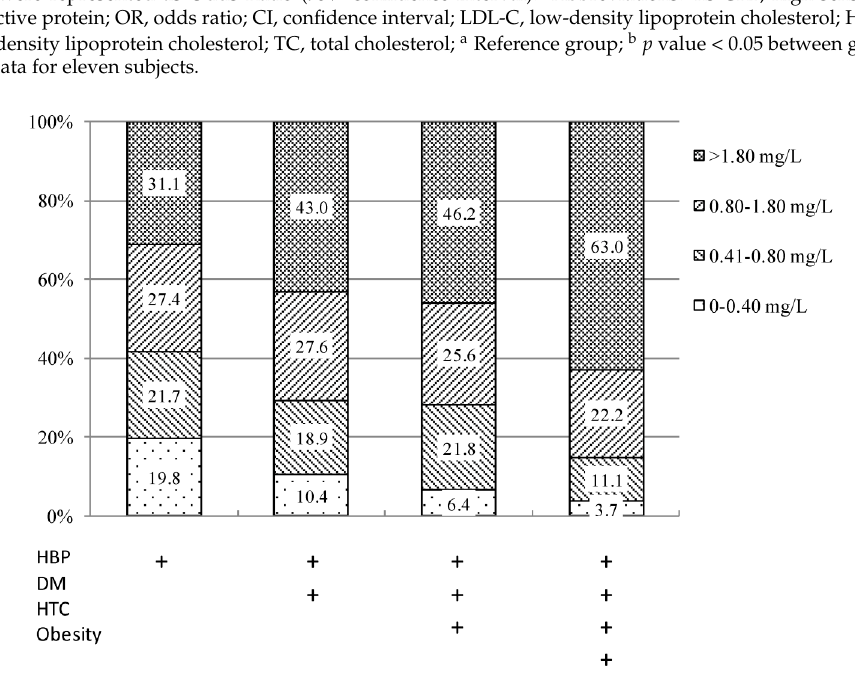
Figure 1. Proportion of hs-CRP in patients with different risk factor combinations; Hs-CRP, high-sensitivity C-reactive protein; HBP, high blood pressure; DM, diabetes mellitus; HTC, high total cholesterol.